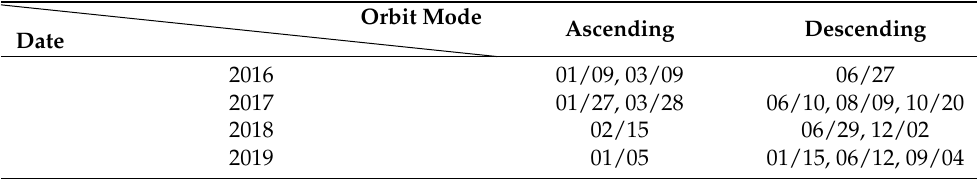
Table 1. The acquisition dates of Sentinel-1A